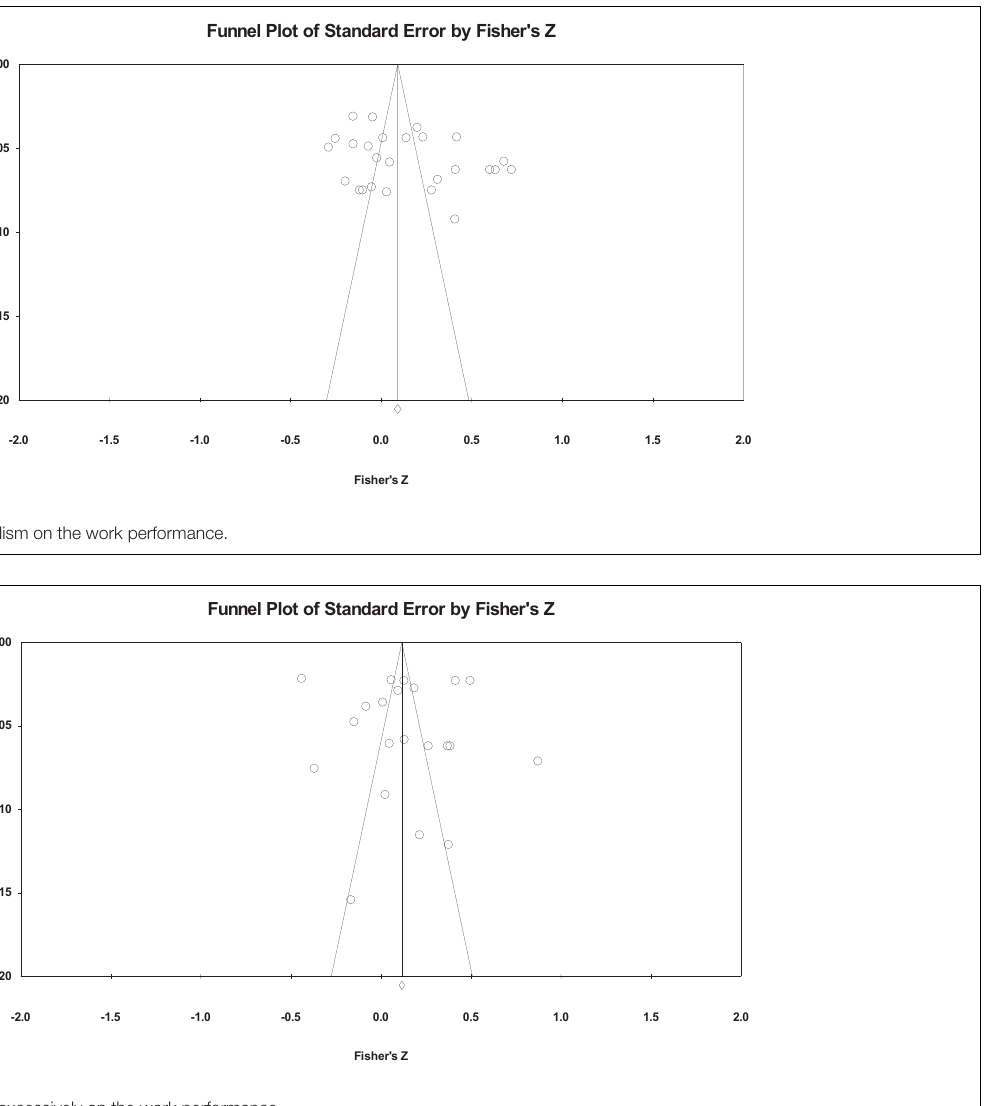
FIGURE 3 | Funnel plot of working excessively on the work